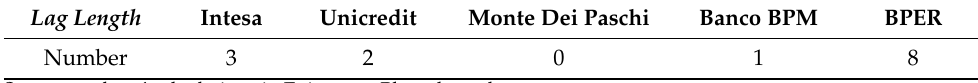
Table 2. Augmented Dickey – Fuller Test: period of January 2015–December 2021. Table 3. AIC optimal lag